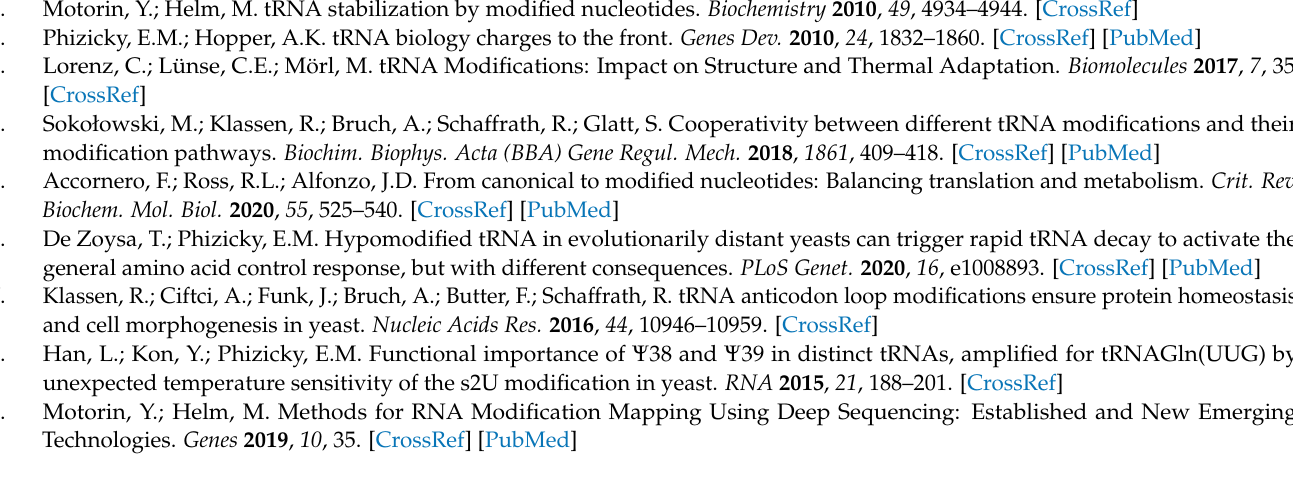
Figure S3: Drug sensitivities of gene deletion mutants in the SSD1-v background. Figure S4: Rescue of the lethality of deg1 urm1 and deg1 elp3 strains. Figure S5: Densiometric analysis of protein aggregation shown in Figure 5. Figure S6: 5-fluorouracil (5-FU) phenotype of tRNA modification mutants in ssd1-d and SSD1-v